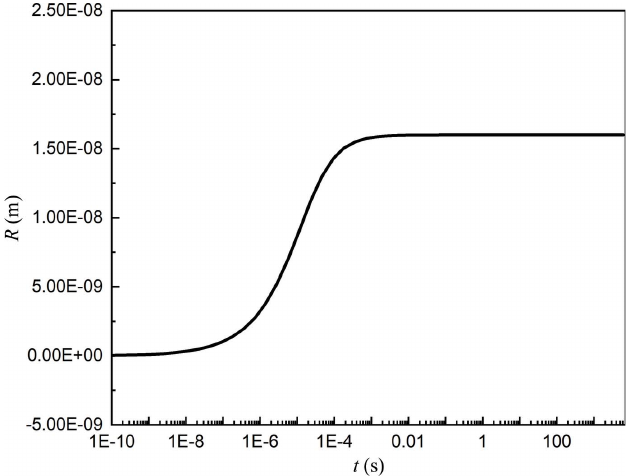
Figure 7 Behavior of the OTBN cluster radius as a function of time. Figure 8